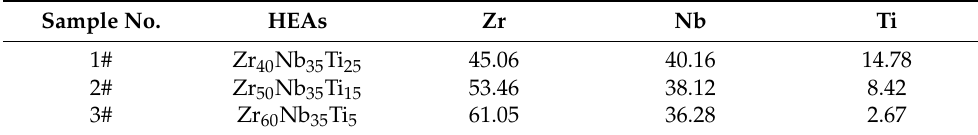
Table 1. Nominal composition (at. %) of the three HEAs.